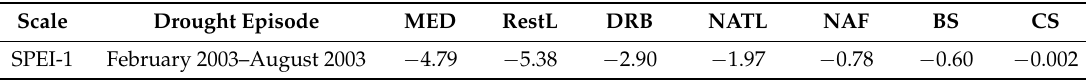
Table 4. Same as Table 3, but for the 2003